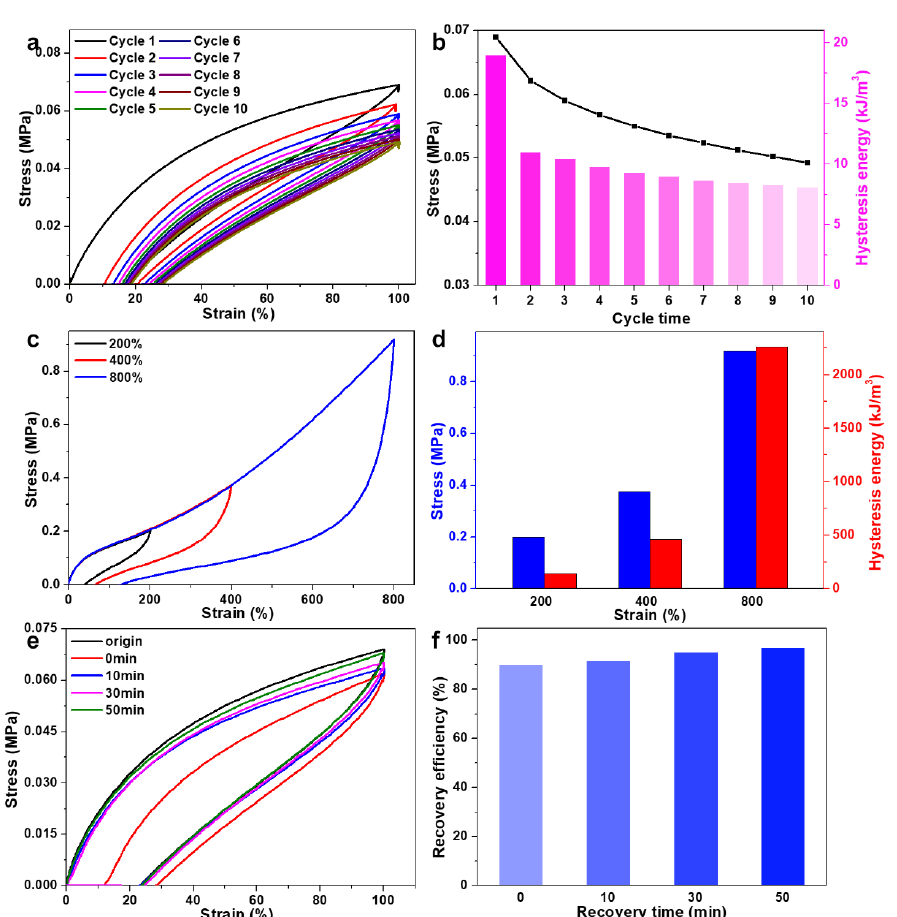
Figure 6. Anti-fatigue performance of the CS/PAA DN ionogel: cyclic tensile curves ( a ) and corre- sponding stress and dissipated energy values ( b ) for 10 consecutive cycles under a strain of 100%; cyclic tensile curves ( c ) and the value of stress and dissipated energy ( d ) under different maximum strain; cyclic tensile curves ( e ) and corresponding recovery efficiency ( f ) after different relaxation time.